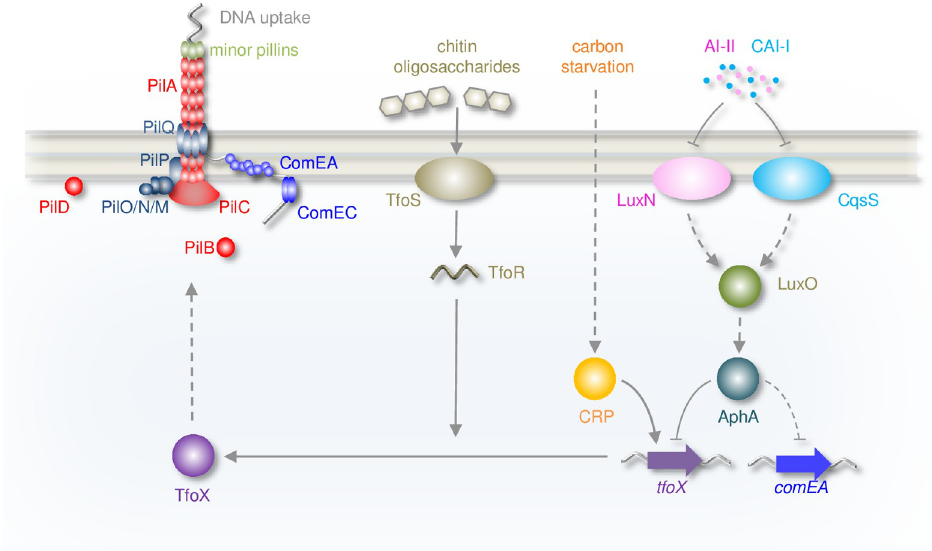
Fig 6. Model for AphA-dependent regulation of natural competence. The diagram illustrates regulatory pathways controlling the induction of natural competence. Solid and dashed arrows represent direct and indirect activation respectively. Barred lines indicate repression. Proteins are shown as ovals and spheres whilst genes are shown as arrows. Nucleic acids are shown as grey (DNA) or peach (RNA) wavy lines. The DNA uptake machinery comprises PilABCD, PilQPONM, ComEA, ComEC, VC0857 and VC0858 (encoding the minor pilins). Repression of competence by AphA primarily occurs at the level of tfoX repression. A small number of factors and intermediary steps have been omitted for